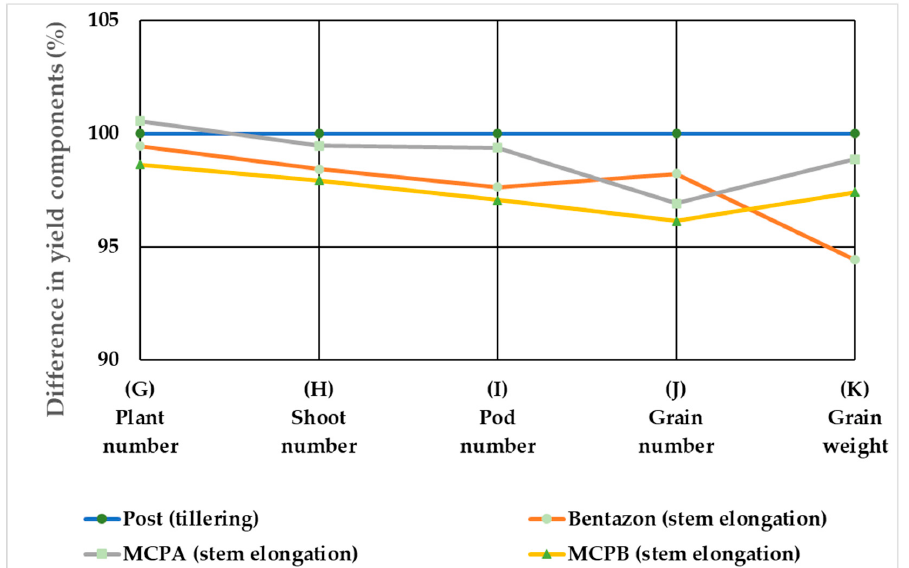
Figure 9. The effect of pre-emergence treatments on the development of winter pea ( Pisum sativum L.) in post-emergence weed management at stem elongation, over an average of 2 years.